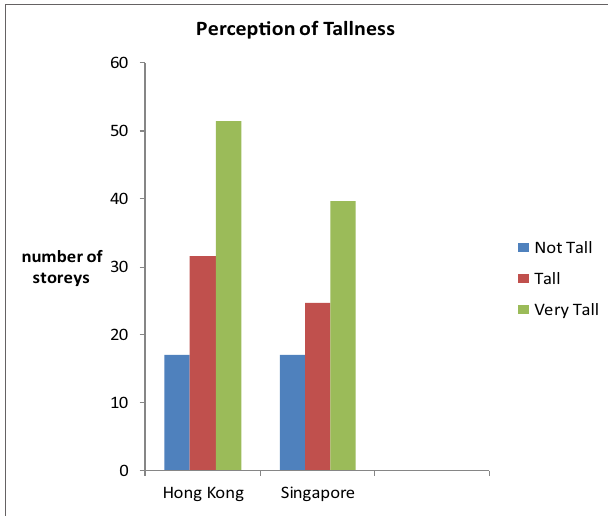
FiguRe 1 | Perception of tallness. Source: Yeh and Yuen